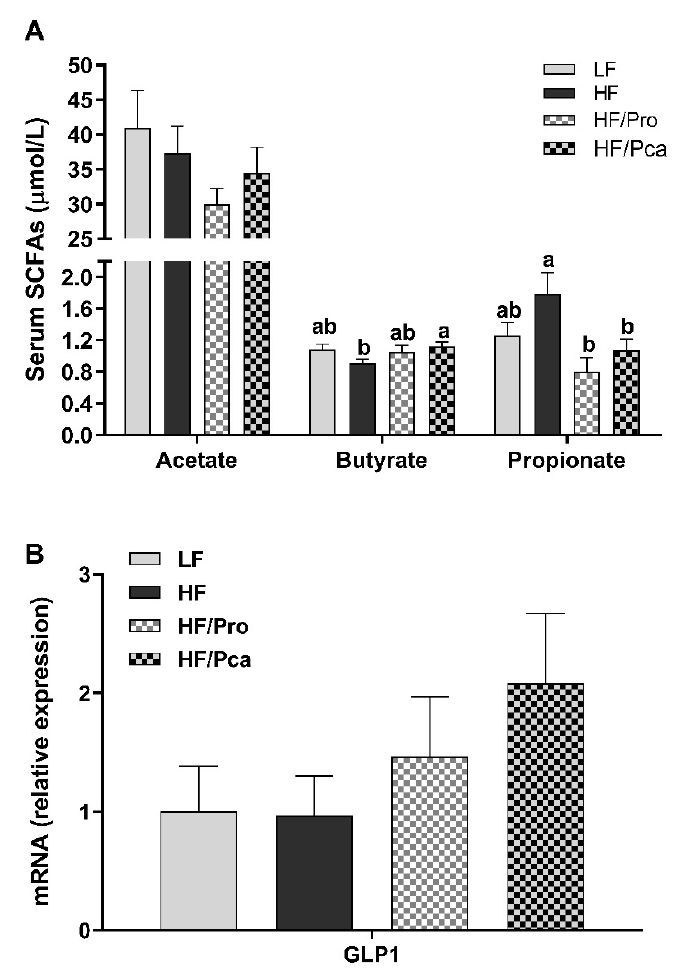
Figure 4. Compositional changes in gut microbiota by non-encapsulated or encapsulated probiotic supplementation were associated with changes in serum concentration of SCFAs ( A ) with no significant difference in gene expression of GLP-1 in the ileum ( B ) of rats fed an LF, HF, HF/Pro, or HF/Pca diet for seven weeks. Values are means ± SEMs; n = 8/group. a,b,c means with different letters are statistically significant, p < 0.05. GLP-1, glucagon-like peptide 1; HF, high fat; HF/Pca, HF with supplemented with encapsulated L. casei W8 (4 × 10 7 cfu/g diet); HF/Pro, HF supplemented with non-encapsulated L. casei W8 (4 × 10 7 cfu/g diet); LF, low fat; SCFA, short chain fatty acid.